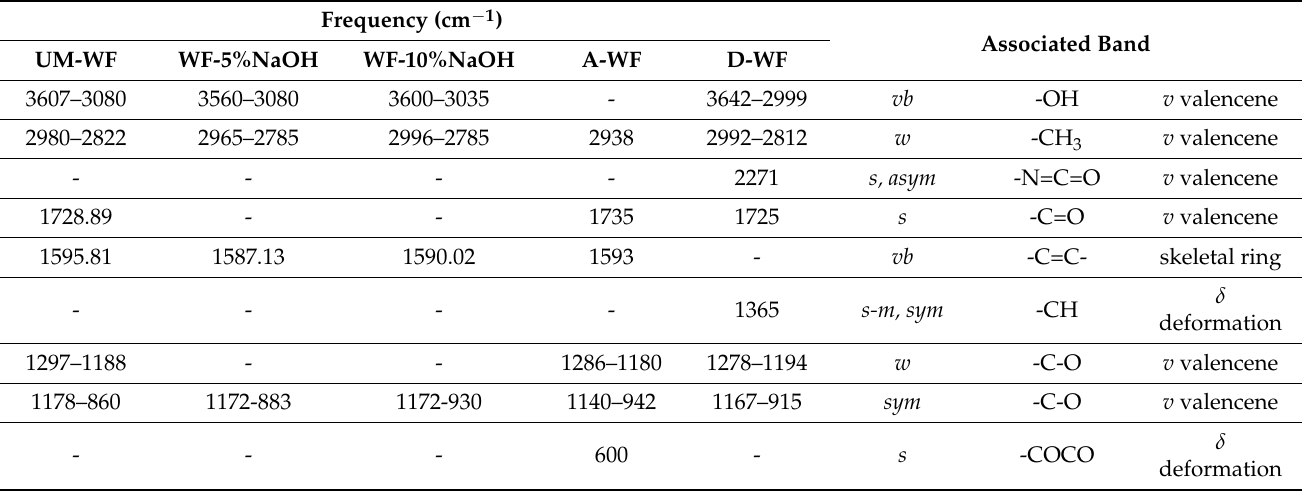
Figure 3. FT-IR spectrum of unmodified and chemically modified waste oak flour (UM-WF — un- modified wood flour; WF-10%NaOH — wood flour mercerized using 10% solution of NaOH; A- WF — acetylated wood flour; D-WF — wood flour modified with MDI). Table 1. FT-IR analysis of unmodified and modified waste oak flour [51 – 53].